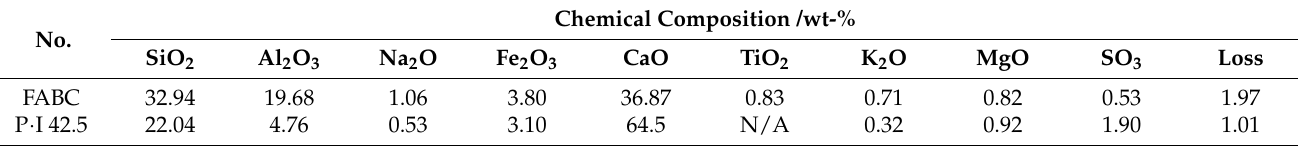
Table 1. Chemical composition of FABC and P · I